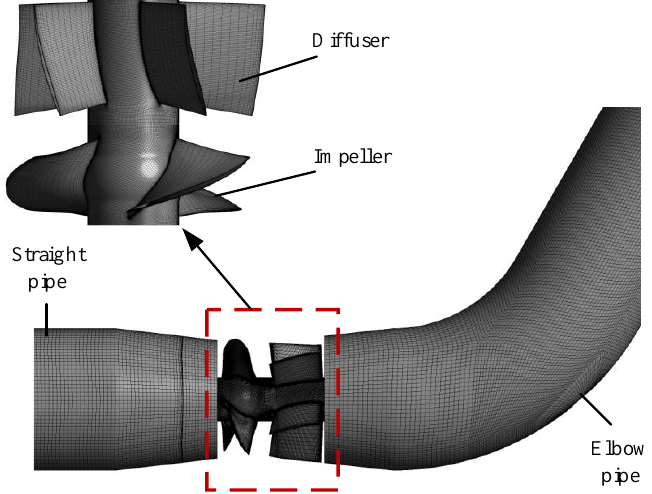
Figure 2. Mesh of the original design.